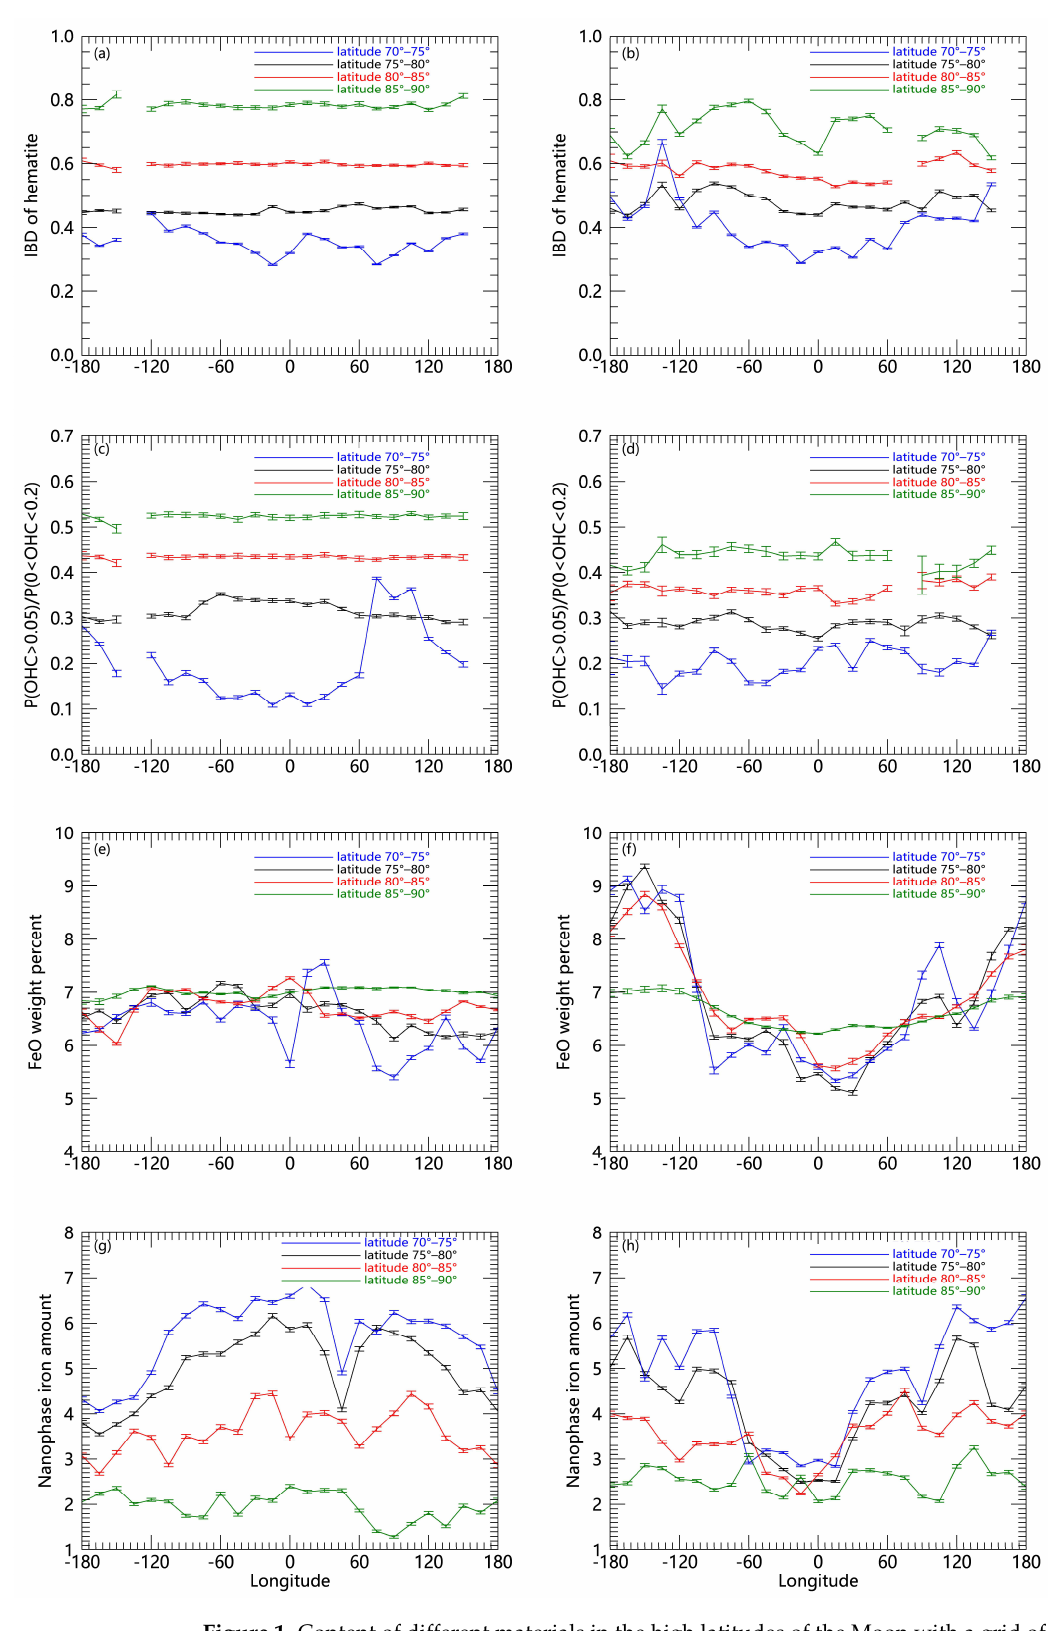
Figure 1. Content of different materials in the high latitudes of the Moon with a grid of 5 ◦ (longitude) × 15 ◦ (latitude) and the mean value is used in each region. ( a , b ) The IBD of hematite. ( c , d ) The probability of 2.8 µ m absorption depth between 0.05 and 0.2 represents the OH/H 2 O abundance level. ( e , f ) FeO weight percent ( g , h ) Nanophase iron